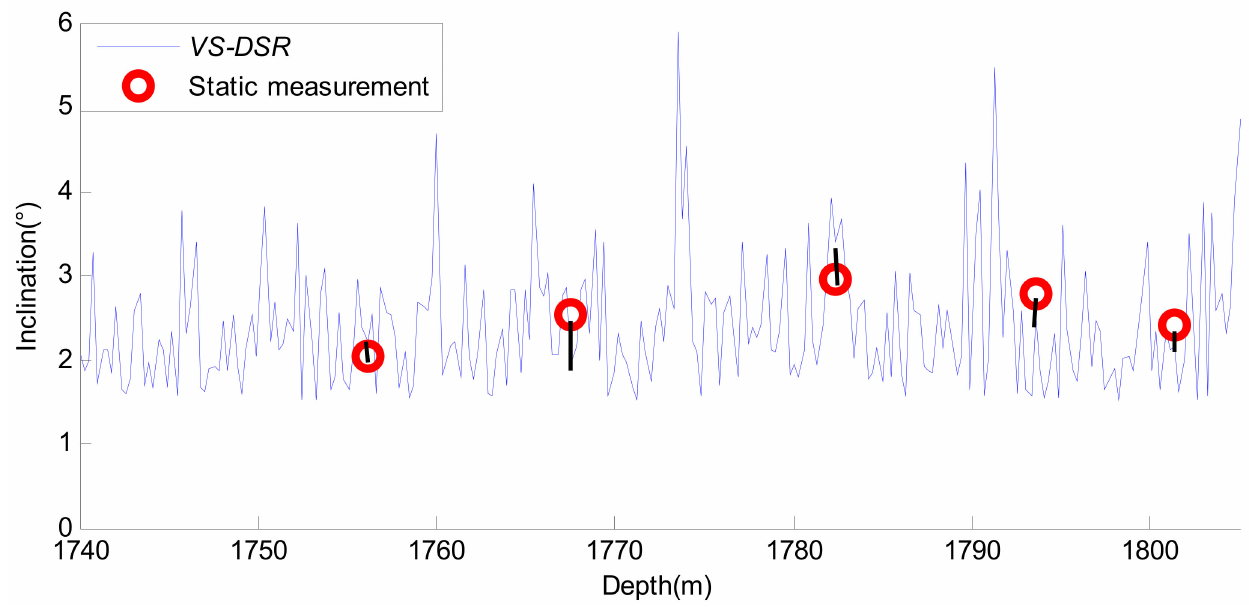
Figure 12. Solving the result of the inclination at northern Shaanxi.